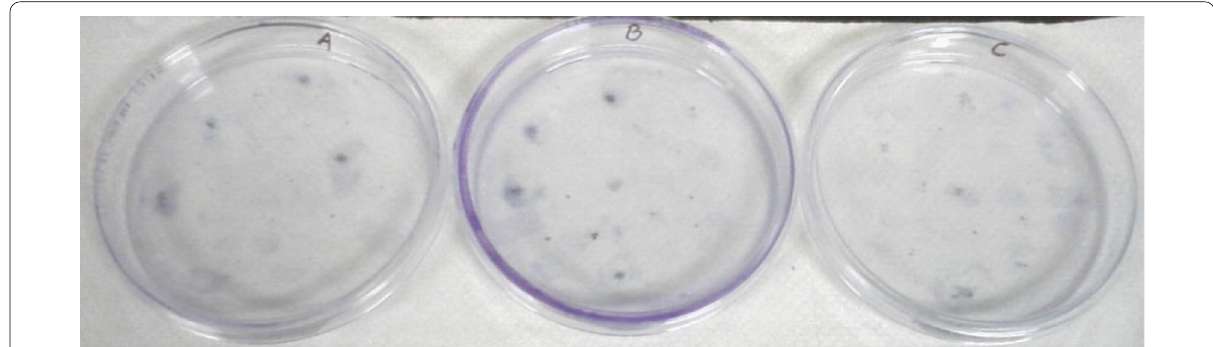
Fig. 3 CFU-F Colony formation (day 7) initiated. Human umbilical cord-derived stem cells expanded in A 5%, B 10% and C 15% FCS from Hyclone, respectively